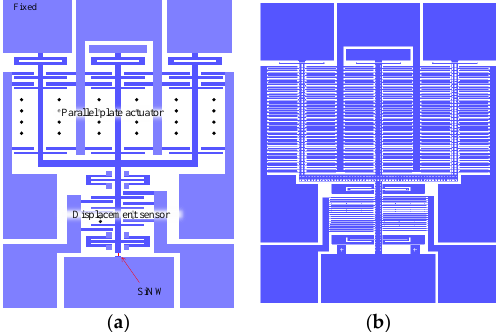
Figure 1. Design of electrostatic tensile testing device. ( a ) Schematic diagram. Light blue parts indicate the fixed regions; ( b ) mask design.